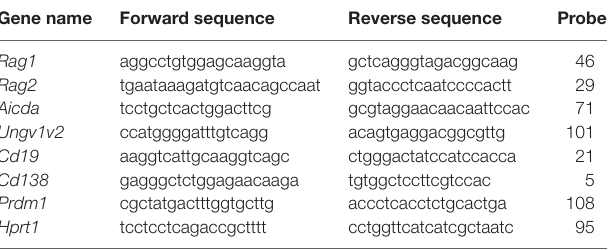
TaBle 1 | Quantitative PCR (qPCR) primers and